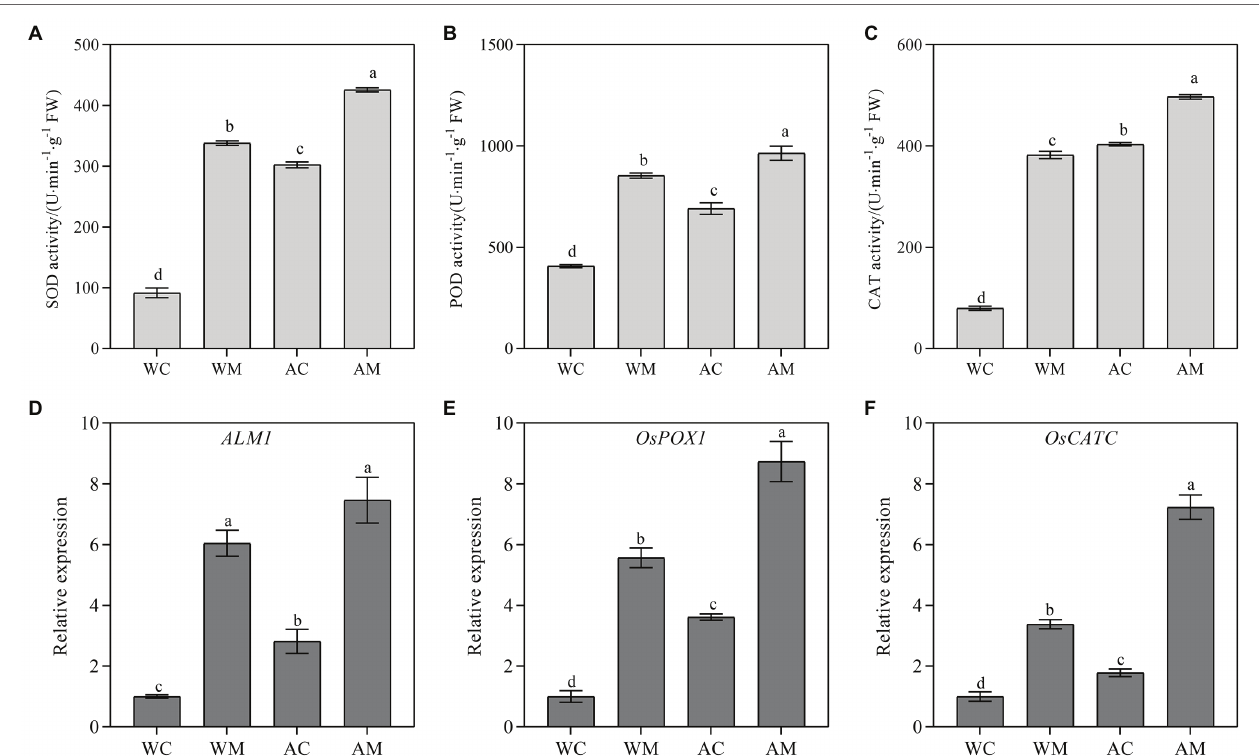
FIGURE 5 | Effects of exogenous MT on antioxidase activity and antioxidant enzyme synthesis-related gene expression. (A) SOD activity; (B) POD activity; (C) CAT activity; and (D–F) ALM1 , OsPOX1 , and OsCATC relative expression level. Data represent means ± SEs of three replicate samples. Different letters denote significant differences ( n = 3, and p < 0.05). WC, control; WM, control pretreated with MT; AC, alkaline stress; and AM, alkaline-stressed plants pretreated with